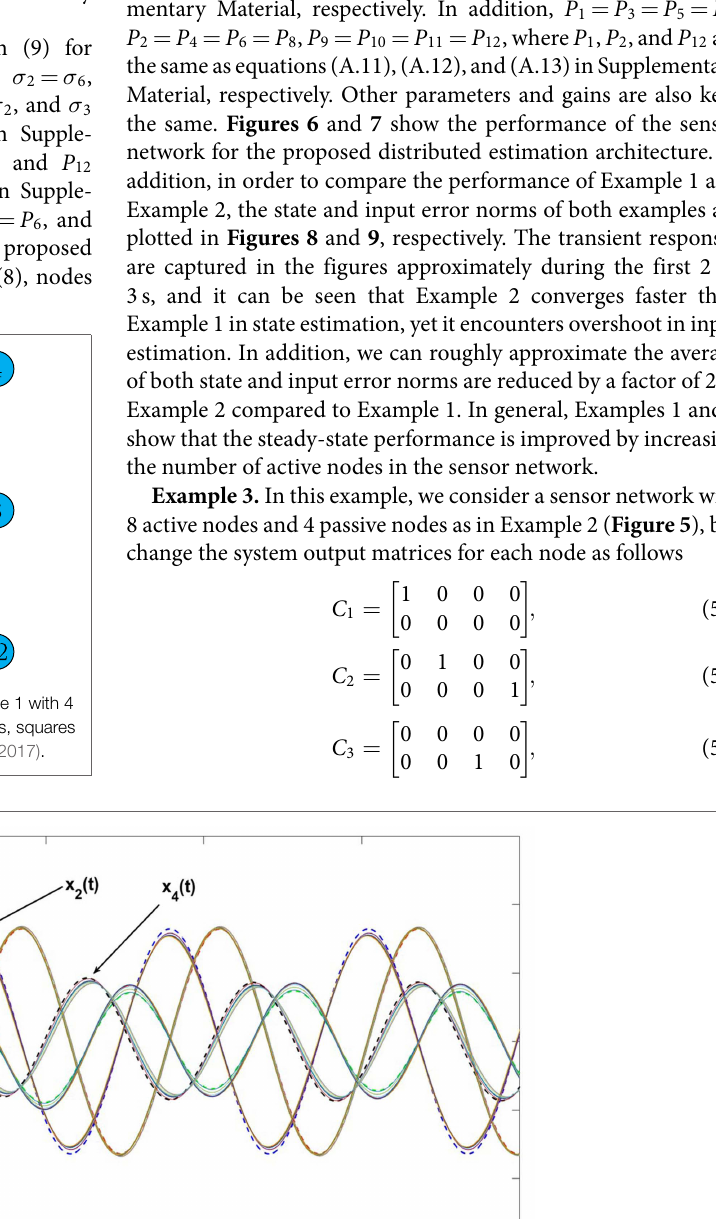
Fr ontiers in Robotics and AI |